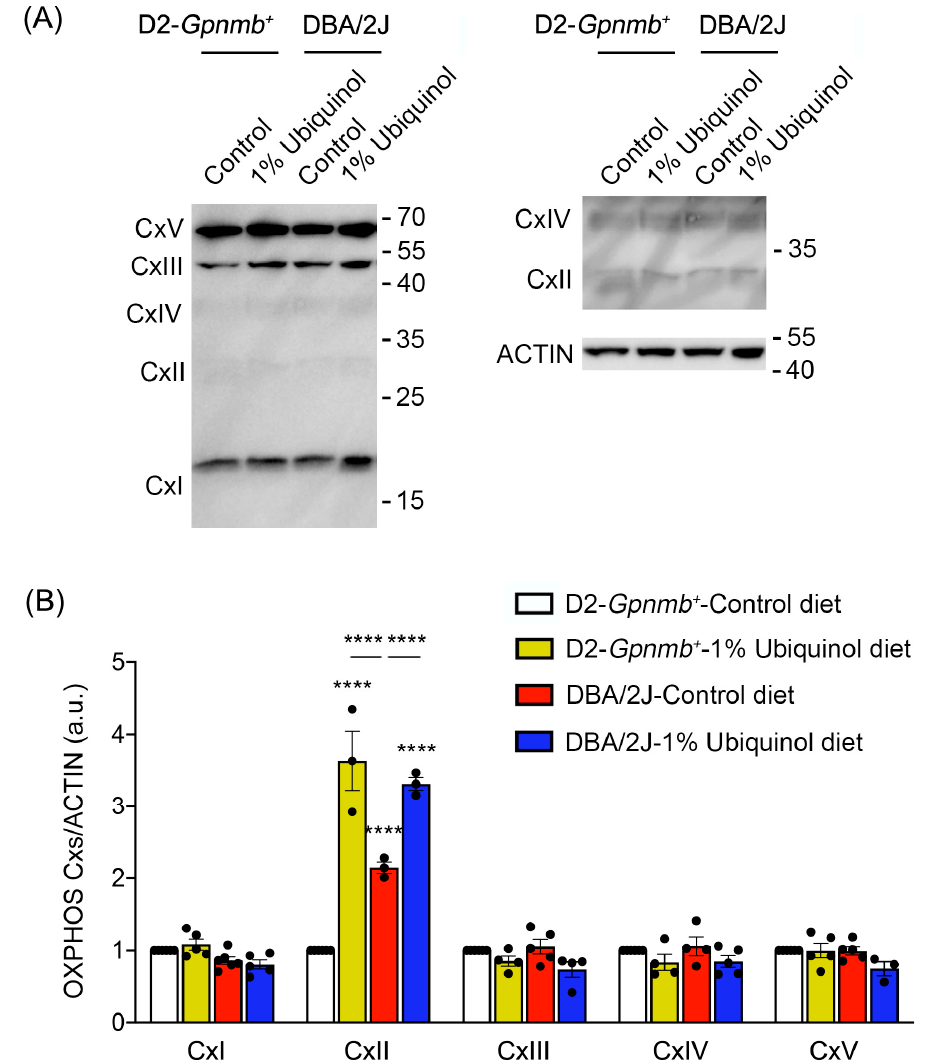
Figure 5. Effect of ubiquinol on oxidative phosphorylation ( OXPHOS) complexes in the retina of glaucomatous DBA / 2J mice. ( A , B ) Western blot analysis for OXPHOS complexes protein expression in the retina. Data are expressed as mean ± SEM ( n = 4 retinas / mice / group). **** p < 0.0001 (two-way ANOVA with the Bonferroni post hoc test).